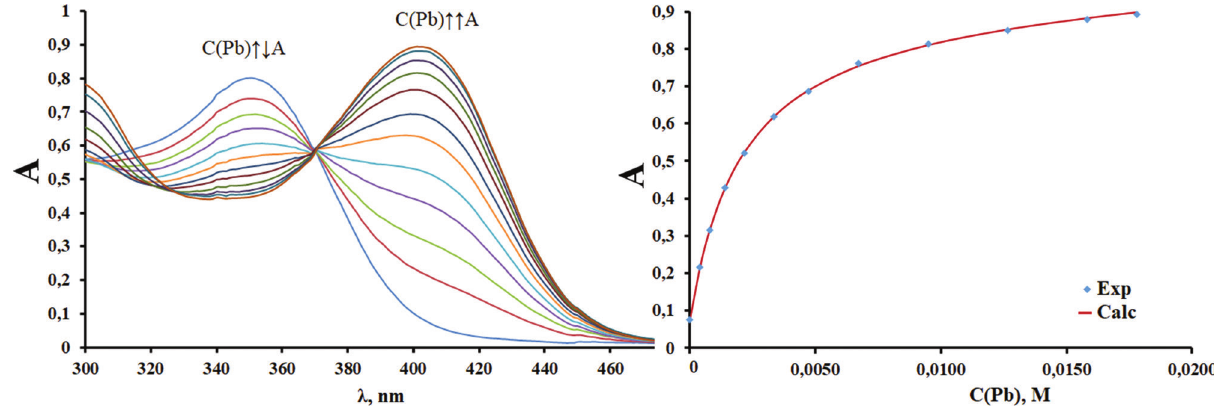
Figure 1: The UV–Vis spectra and absorbance at single wavelength (404 nm) for Pb 2+ -Morin system; C(Morin) = 6.87·10 -5 M; pH=2.80, I=0.5 M.